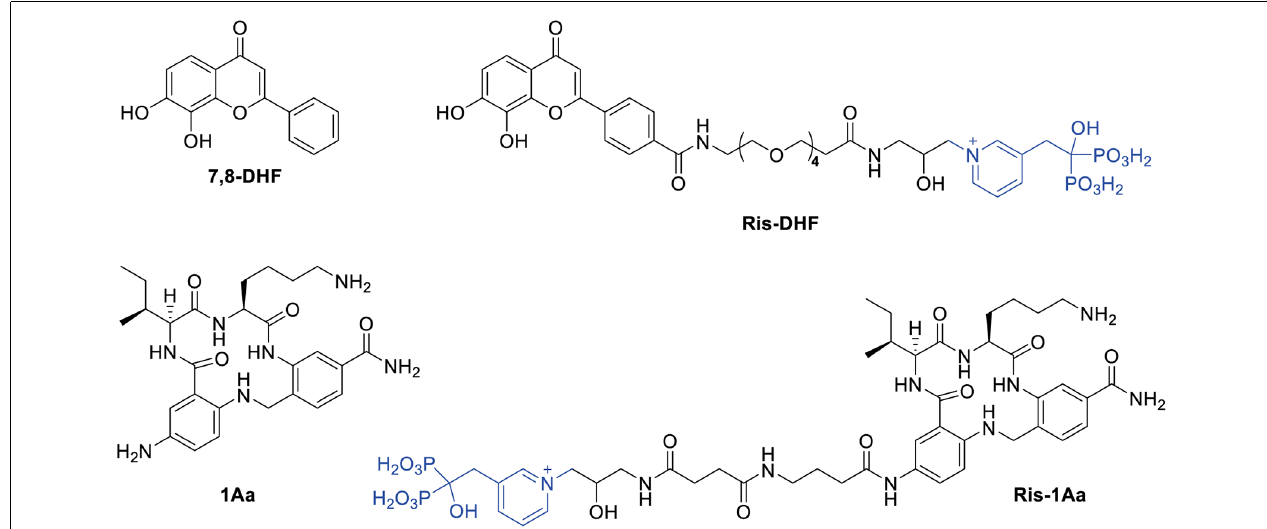
FIGURE 1 | Structures of 7,8-DHF, 1Aa, and their conjugates with risedronate (Ris).